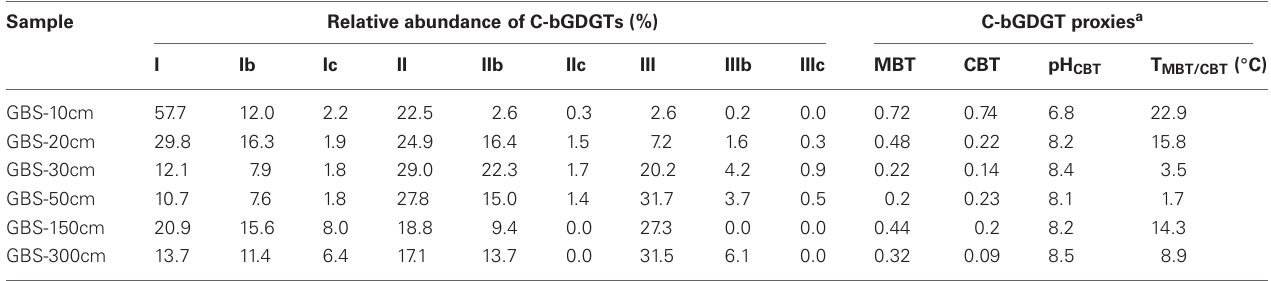
Table A1 | Relative abundances of Core (C)- bGDGTs and C-bGDGTs-derived proxies for soil samples collected along the transect from GBS. Sample Relative abundance of C-bGDGTs (%) C-bGDGT proxies